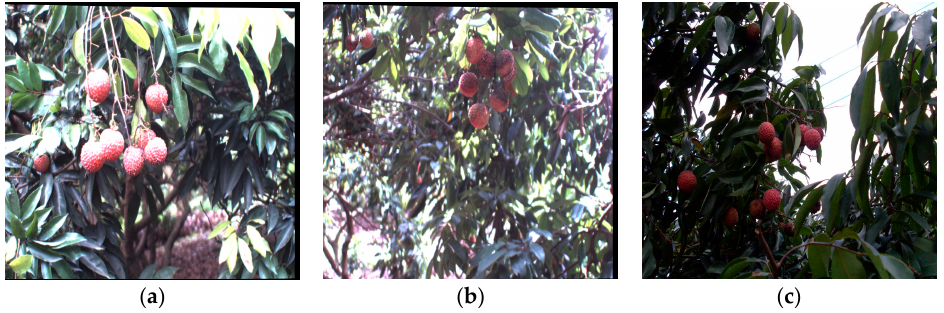
Figure 11. Original litchi color images under different illumination conditions. ( a ) Original litchi color image under front-lighting conditions; ( b ) Original litchi color image under back-lighting conditions; ( c ) Original litchi color image under cloudy day